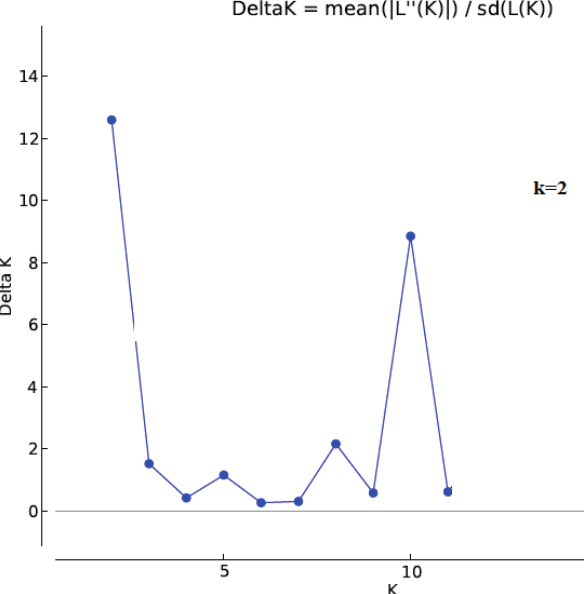
Figure 4. Delta k plot of Evanno’s test based on STRUCTURE anal-